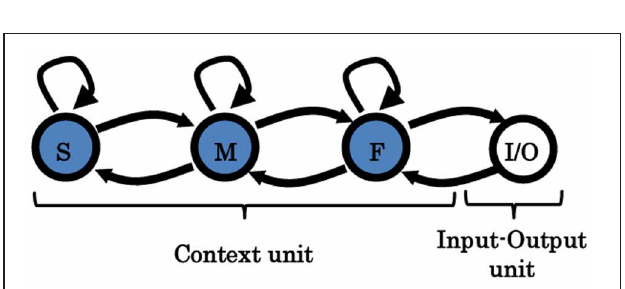
FIGURE 6 | Three-level MTRNN model. Arrows indicate the direction of the synaptic connections between the units. In contrast to the two-level model, F and S are indirectly connected throughout the mid-context unit (M) to increase the distance between